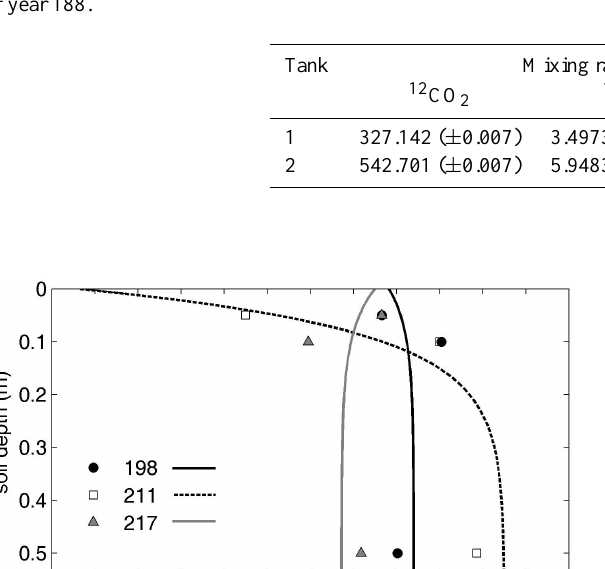
Table 2. CO 2 isotopologues mixing ratio ( ± mean standard error) of secondary calibration tanks obtained during weekly calibration on day of year 188.